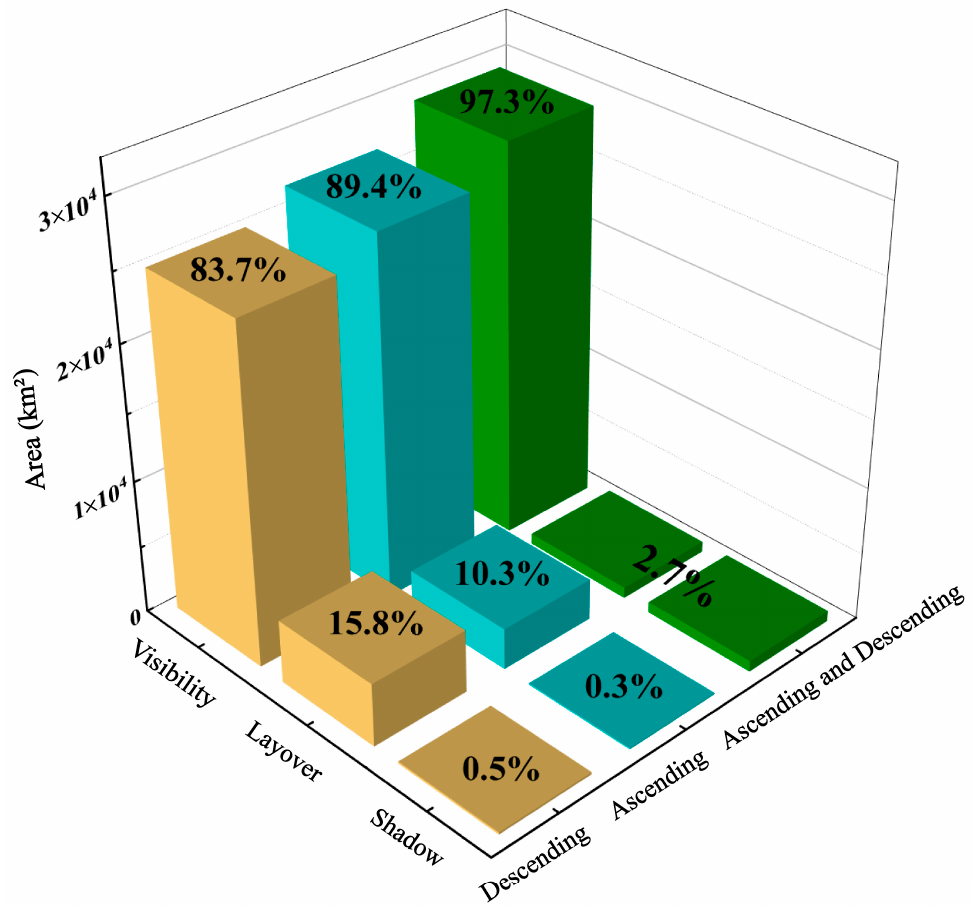
Figure 10. Geometric distortion (layovers and shadows)